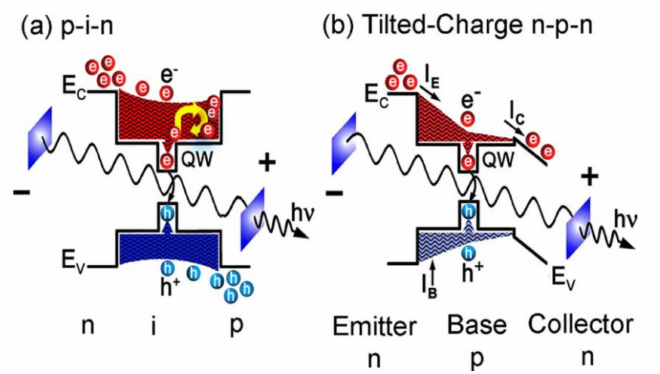
Figure 3. ( a ) Energy band structure and carrier population distribution of PIN-type double heterojunc- tion DML; it is uniformly distributed, which induces accumulation. ( b ) Energy band structure and carrier density distribution of TL; it has a skewed distribution of carriers due to base transition [23]. Reproduced from Ref. [23], with the permission of AIP